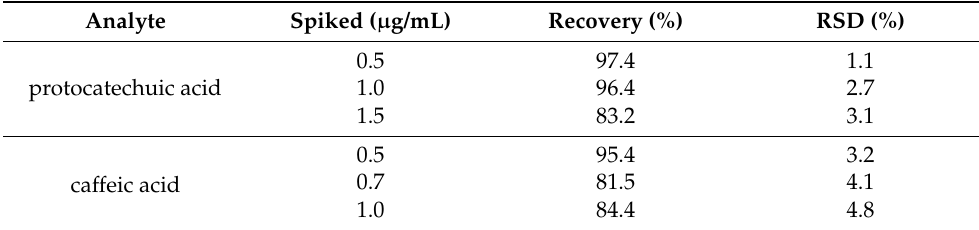
Table 5. Recoveries (%) of protocatechuic acid and caffeic acid spiked at different levels using LVSS-MEKC in Cibotium barometz